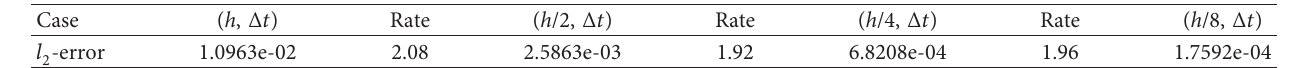
Table 14: Convergence test results of the SAV approach for space